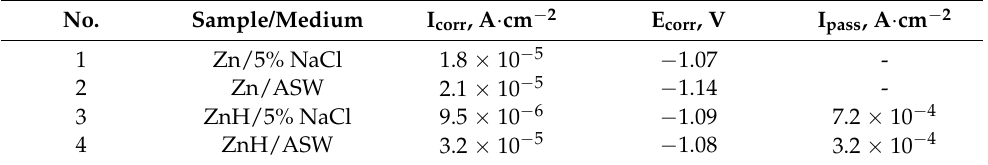
Table 1. Electrochemical parameters obtained from potentiodynamic polarization measurements.